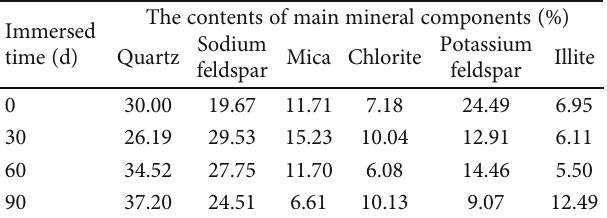
Figure 4: Variation curves of mass of specimens under the action of chemical solution. Table 1: Contents of the main minerals of granites during the immersed